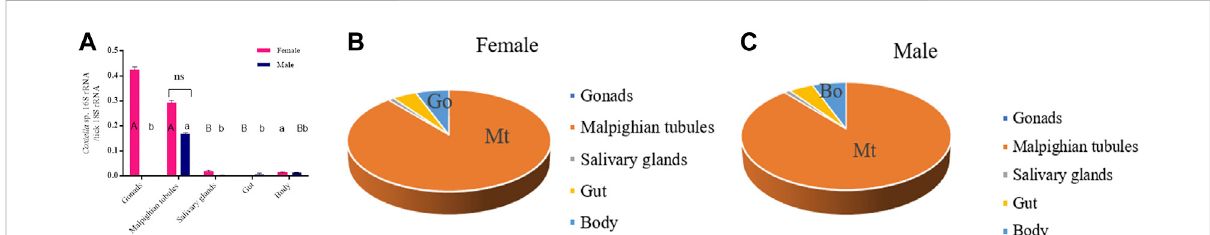
FIGURE 4 Quanti fi cation of Coxiella in different Rh. sanguineus organs using qPCR. (A) Coxiella in the gonads, Malpighian tubules, trunk, midgut, and salivary glands of female ticks ( n = 15, 10, 20, 20, 19, respectively) and male ticks ( n = 12, 10, 11, 11, 11, 11, respectively). Densities were calculated as bacterial 16S rRNA gene targets for each tick 18S rRNA gene target. Uppercase and lowercase letters indicate statistical signi fi cancebetween female and male tick organs. Red, female; blue, male; ns, not signi fi cant. (B,C) Relative abundance of Coxiella in female and male tick organs (percentage of total); orange, Malpighian tubules (Mt); pale blue, gonad.